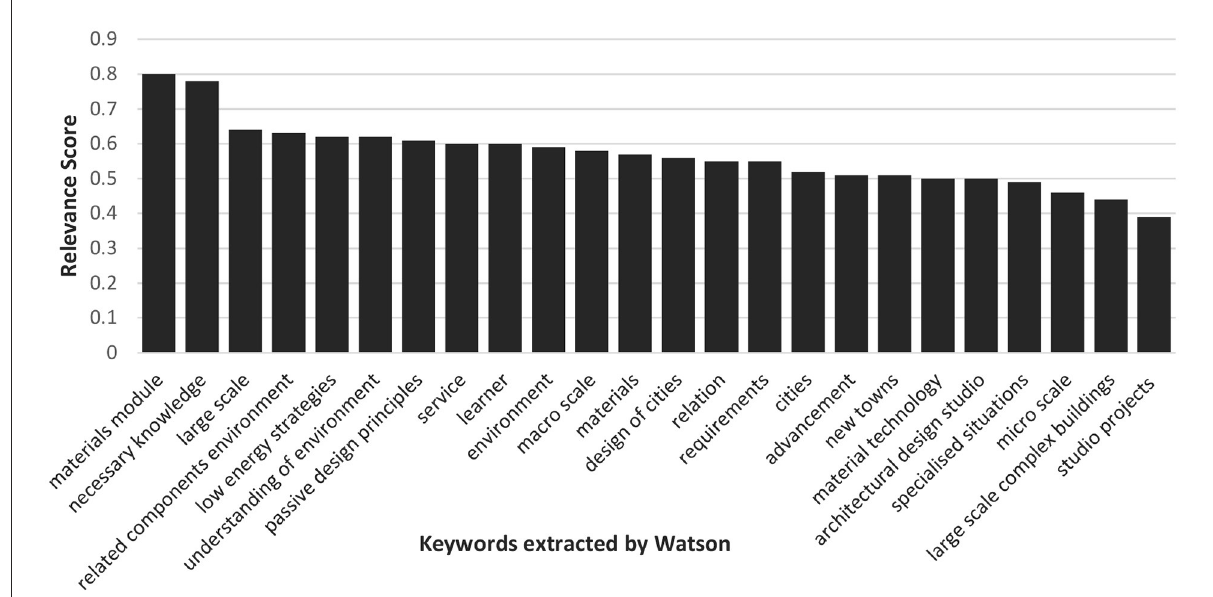
FIGURE2 Relevance scores, on a scale of 0–1, for keywords extracted by Watson from the Environmental Services and Materials module/course